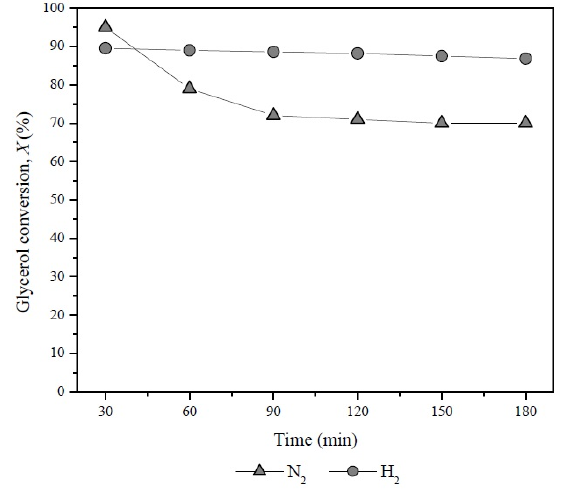
Figure 11. Glycerol conversion with time on stream of the Pd/LaY catalyst with N 2 and H 2 as carrier gas at 548 K, 10 wt % glycerol, 0.3 g of catalyst and GHSV = 5933 h − 1 .